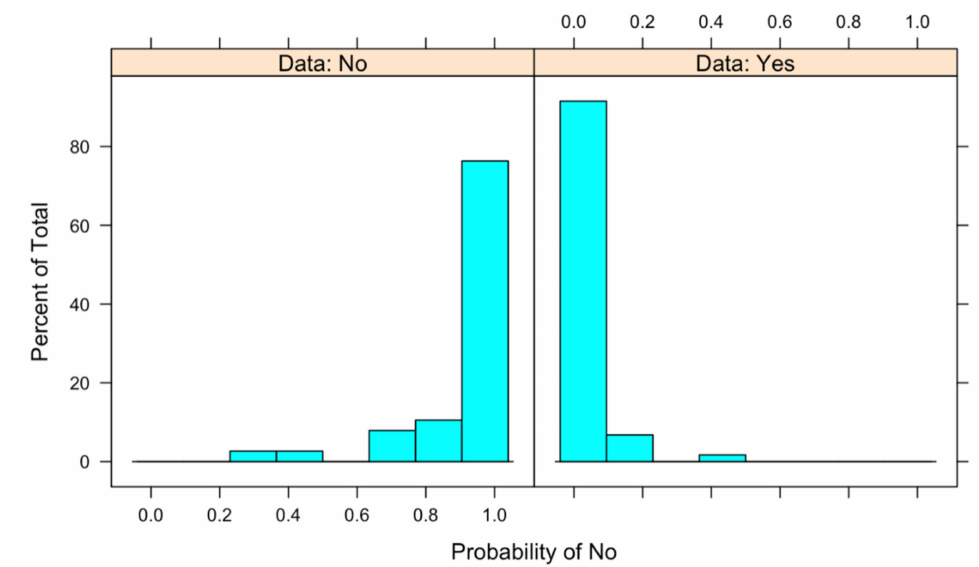
Figure 4. Histogram of probabilities distribution. Random Forest